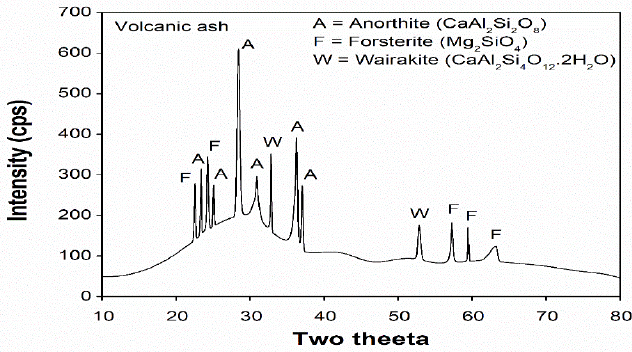
Figure 2. X-ray diffraction analysis of powder sample of volcanic ash